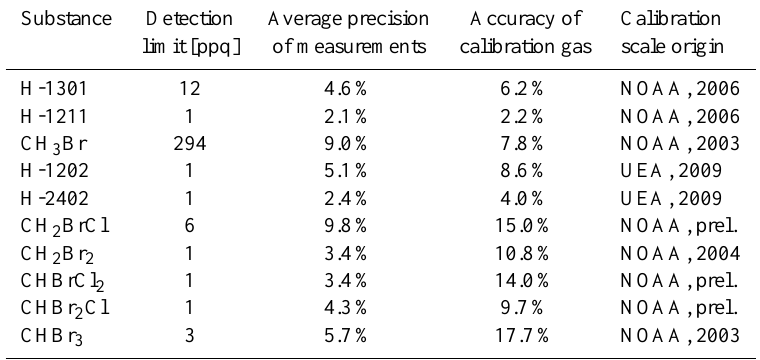
Table 2. Overview of the detection limits and measurement precision of the GHOST-MS and the origin and accuracy of the calibration scales used for the various brominated